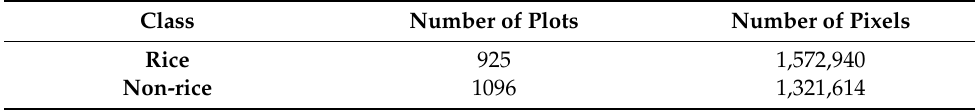
Table 2. Information of the validation data